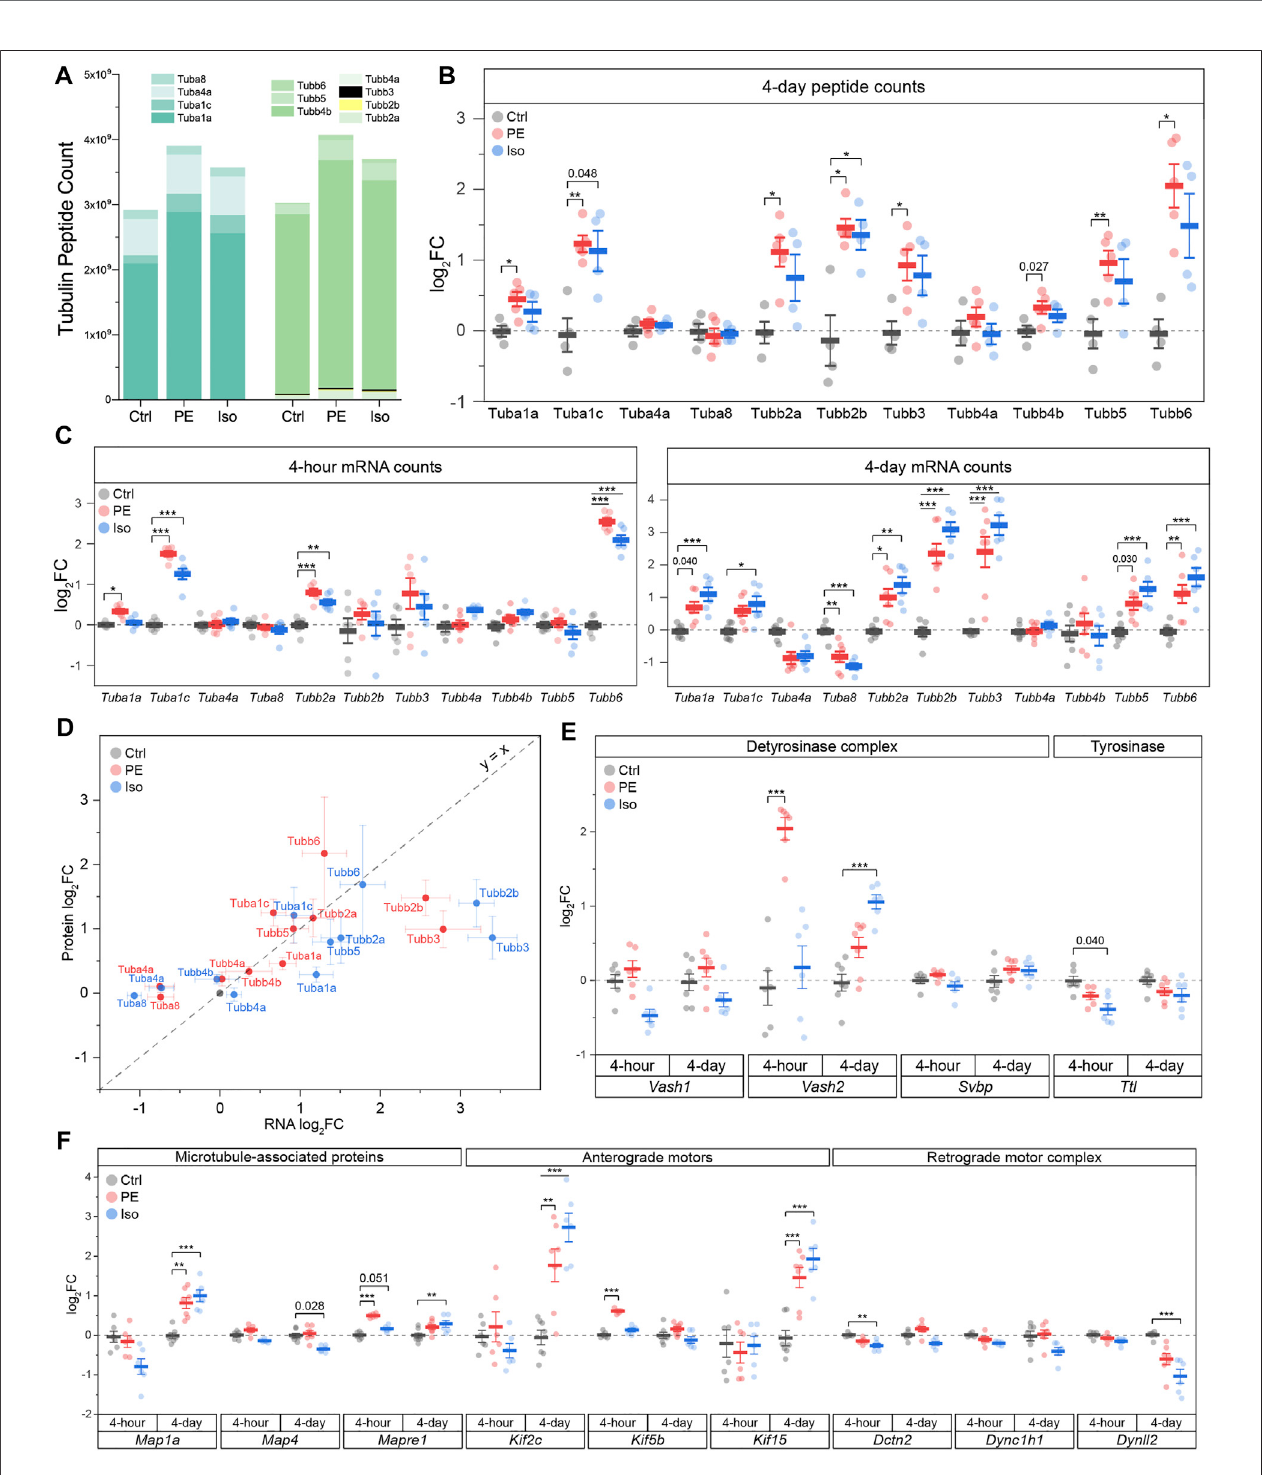
FIGURE 5 | Differential expression oftubulin isoforms, modifying enzymes and MAPs during the onset and establishment ofhypertrophy. (A) MS counts of unique peptides of detectable αβ -tubulin isoforms at 4-days timepoint. For all following box plots, whiskers represent ± 1SEM and bolded line represents mean. (B) Relative log 2 fold-change of αβ -tubulin isoforms peptide counts at 4-days ( n = Ctrl: 4, PE: 5, Iso: 4); * represents p-value from Welch-corrected two-tailed two-sample t-test on non-log data < 0.025 (Bonferroni-corrected for two comparisons), ** represents p < 0.01, and *** represents p < 0.001. (C) relative log 2 fold-change of nCounter